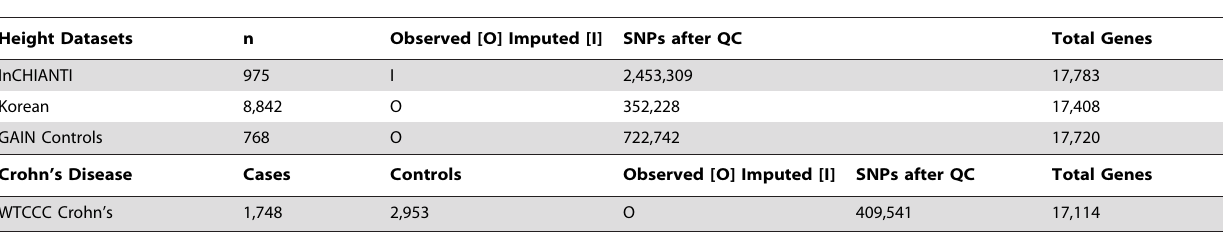
Table 4. Summary of GWAS